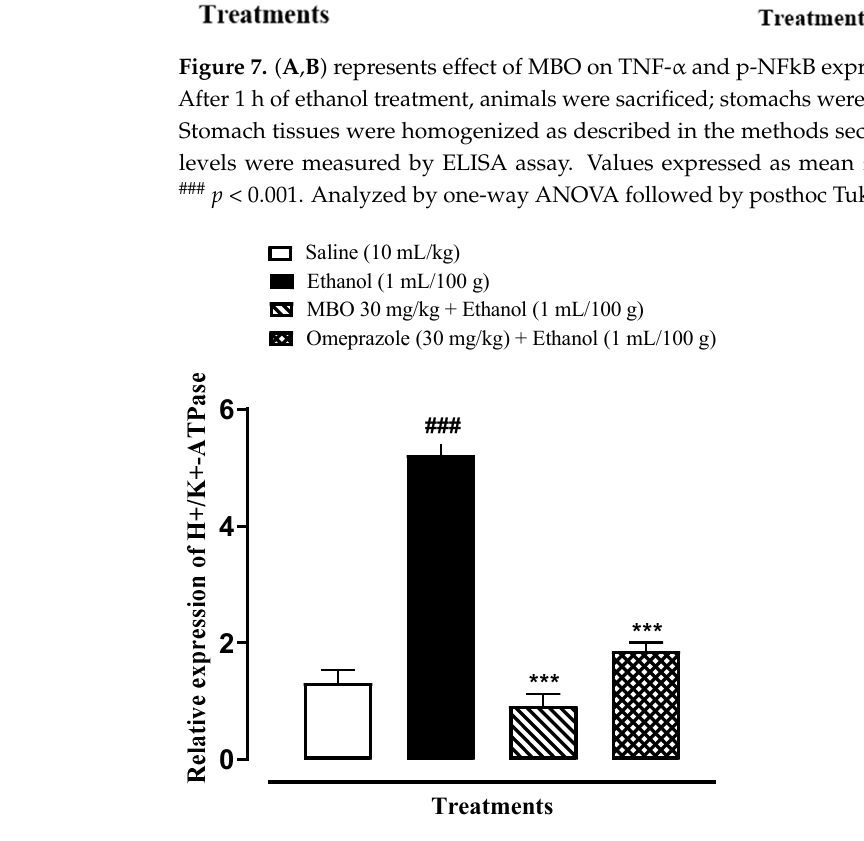
Figure 7. ( A , B ) represents effect of MBO on TNF-α and p-NFkB expression in gastric tissue of rats. After 1 h of ethanol treatment, animals were sacrificed; stomachs were isolated and stored at −80 °C. levels were measured by ELISA assay. Values expressed as mean ± SEM ( n = 3). *** p < 0.001; ### p < 0.001. Analyzed by one-way ANOVA followed by posthoc Tukey’s test.